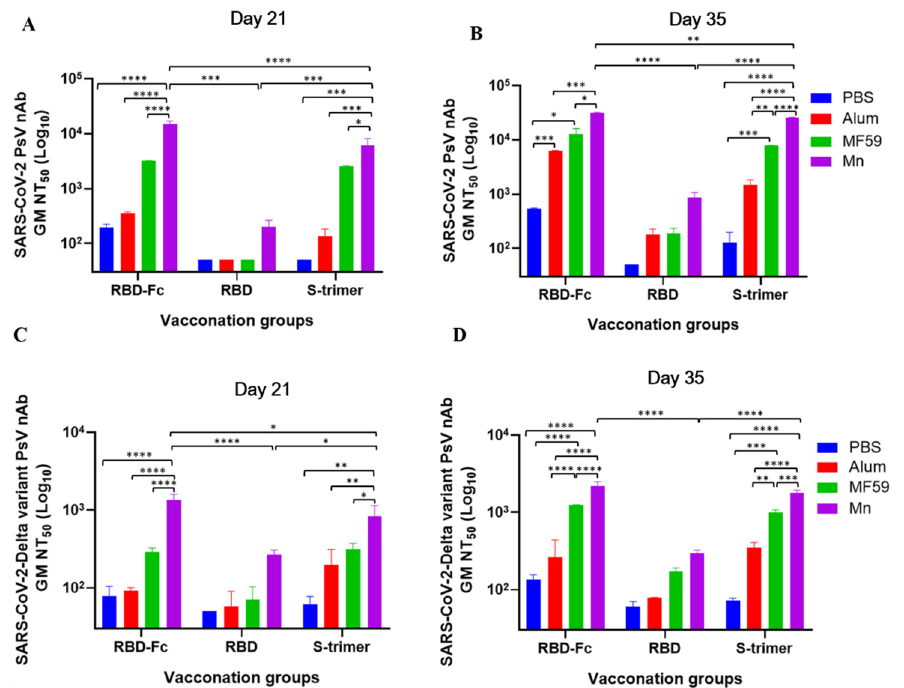
Figure 4. Neutralization activity observed in vaccinated mouse sera on days 21 and 35 against pseudotyped SARS-CoV-2 wildtype (D614G) and Delta variant. Mice immunized with different formulations were capable of producing neutralizing antibody responses to varying extents. Sera collected from mice on days 21 and 35 were evaluated for their content of neutralization antibodies. ( A ) nAbs against SARS-CoV-2 wildtype (D614G) pseudovirus by mouse sera collected on day 21. ( B ) nAbs against SARS-CoV-2 wildtype (D614G) pseudovirus by mouse sera collected on day 35. ( C ) nAbs against SARS-CoV-2 Delta variant pseudovirus by mouse sera collected on day 21. ( D ) nAbs against SARS-CoV-2 Delta variant pseudovirus by mouse sera collected on day 35. Statistical significance was determined by two-way ANOVA and is indicated as follows: * p < 0.05, ** p < 0.01, *** p < 0.001, **** p < 0.0001. Error bars represent SD.